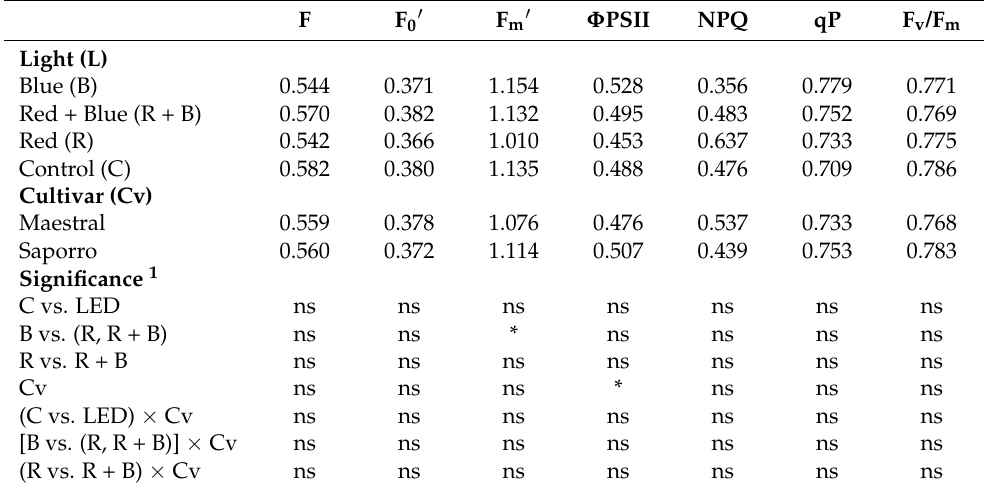
Figure 3. Stomatal conductance ( gs ; A ), transpiration rate ( E ; B ); leaf temperature ( C ) and water use efficiency (WUE; D ) of green bean pods as influenced by interactions between cultivars and light spectra. Vertical bars represent the standard error of mean values. Significance: * = significant for p ≤ 0.05; ** significant for p ≤ 0.01 and *** significant for p ≤ 0.001. Table 5. Effects of light spectra and cultivar on chlorophyll fluorescence parameters of leaves of green